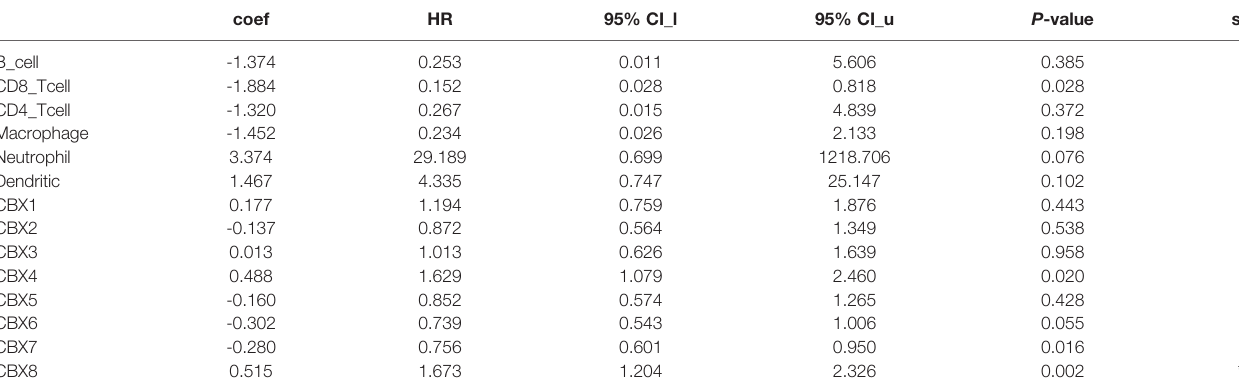
TABLE 2 | The cox proportional hazard model of CBXs and six tumor-in fi ltrating immune cells in ccRCC (TIMER). coef HR 95% CI_l 95% CI_u P -value sig B_cell